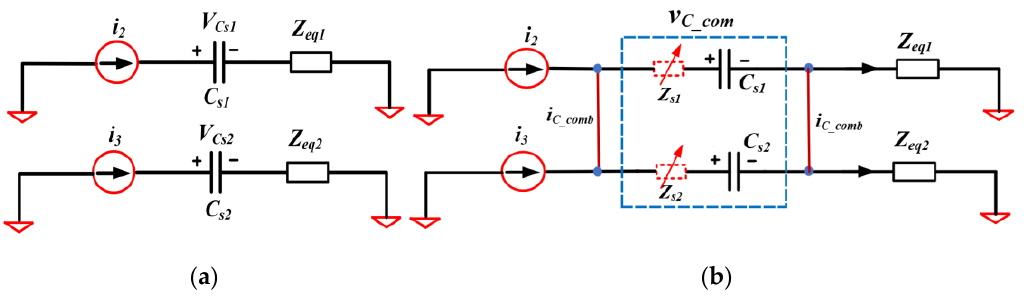
Figure 26. Equivalent circuit of capacitors in LCC-BP receiver coils ( a ) without common capacitor connection, and ( b ) with common capacitor connection.